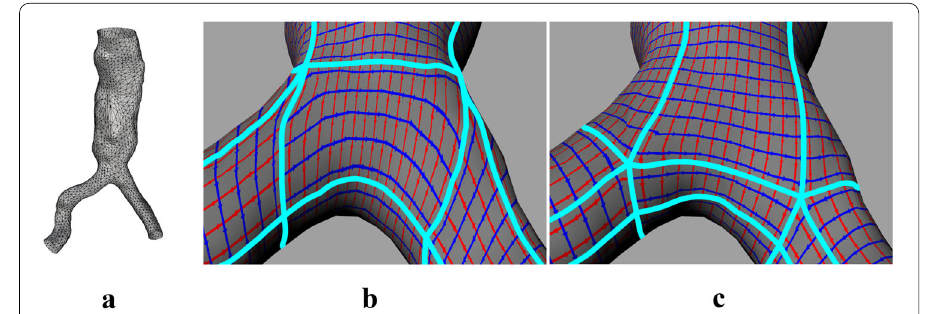
Fig. 13 Abdominal aorta global parameterization. a Input triangulated mesh. b Global parameterization and quadrilateral layout after 1 iteration. c Global parameterization and quadrilateral layout after 25 iterations